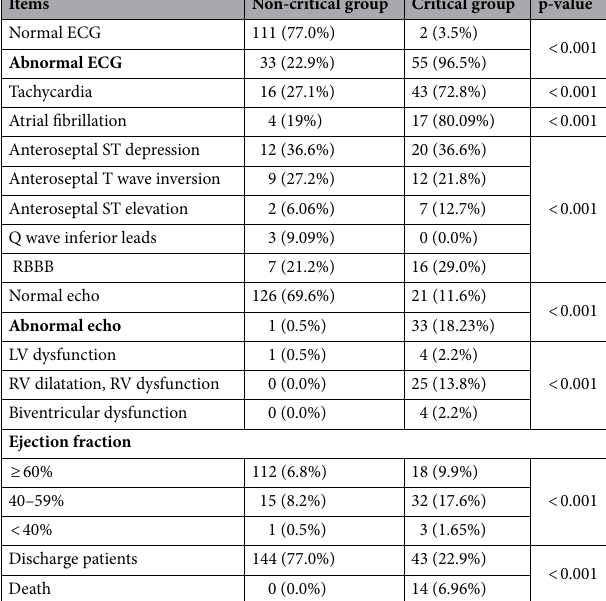
Table 3. Echo and ECG assessment by critical and non-critical cases.